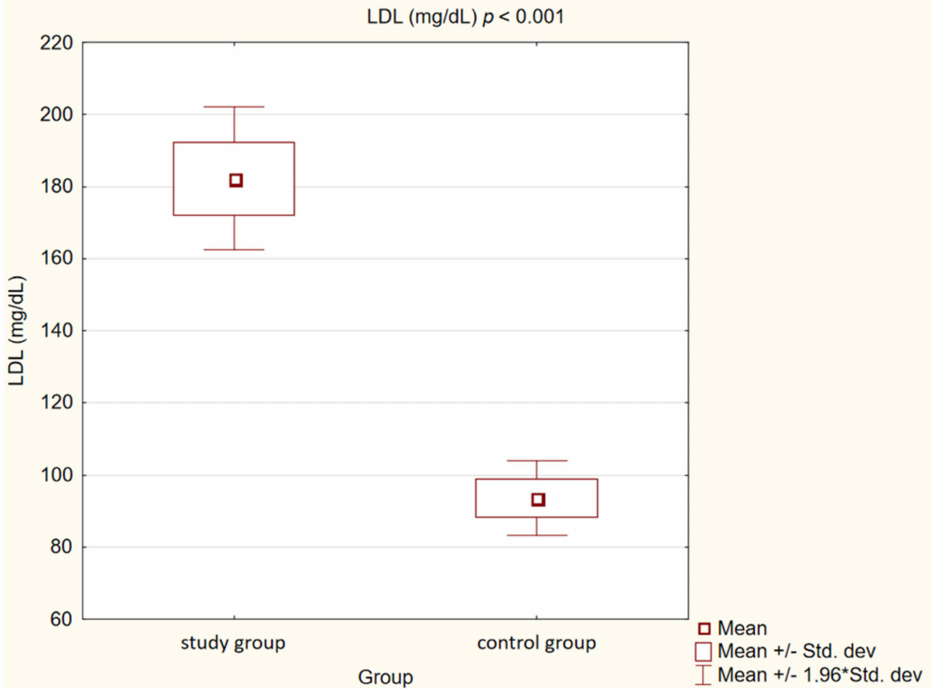
Figure 2. Concentration of low-density lipoprotein cholesterol (LDL) in study and control